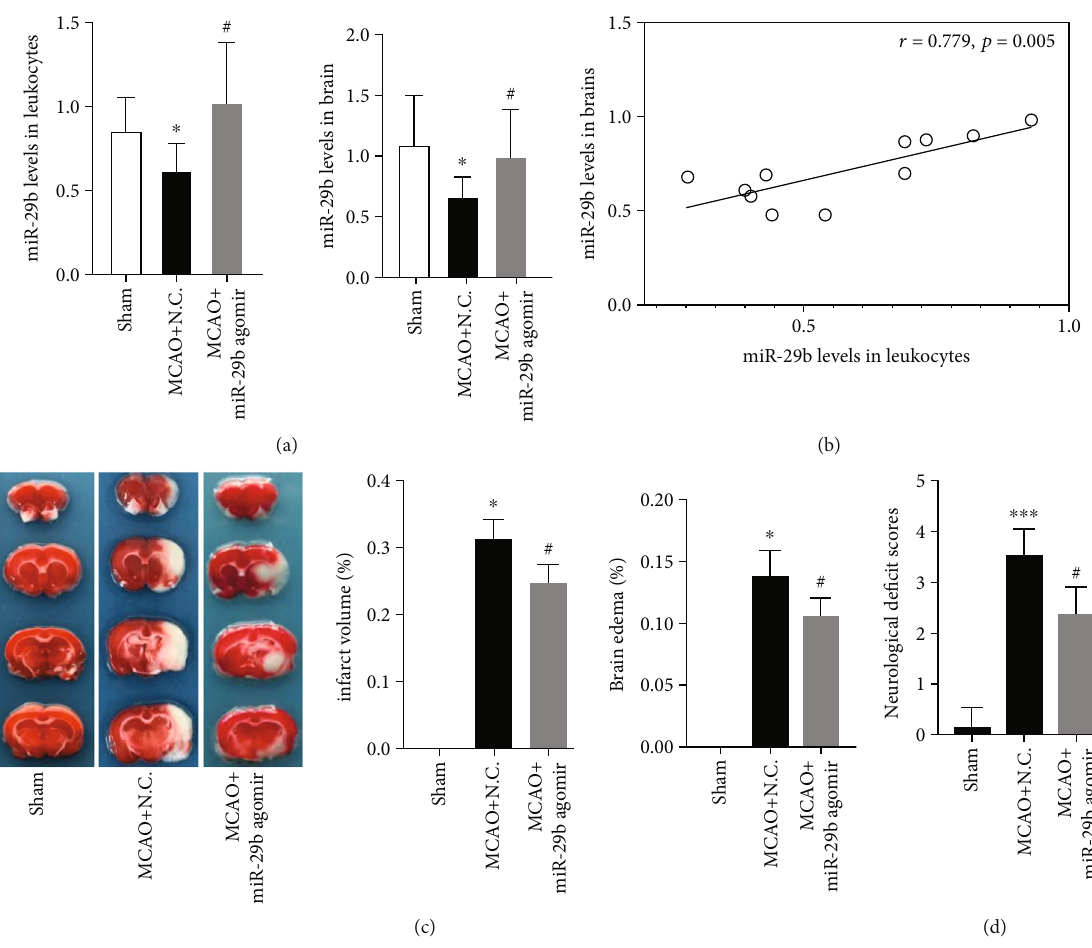
Figure 2: Changes of miR-29b expression and subsequent e ff ects on cerebral injury and neurological de fi cits in middle cerebral artery occlusion (MCAO) rats. (a) The expression of miR-29b in leukocytes and the ischemic brain. N = 9 . (b) The correlation between leukocyte miR-29b and brain miR-29b levels. N = 9 . (c) Cerebral infarct volume and edema evaluated by TTC staining of coronal brain sections. N = 12 . (d) E ff ects of miR-29b on neurological function de fi cits at 24-hour poststroke. ∗ P < 0 : 05 and ∗∗∗ P < 0 : 001 vs. sham group. # P < 0 : 05 vs. MCAO+NC